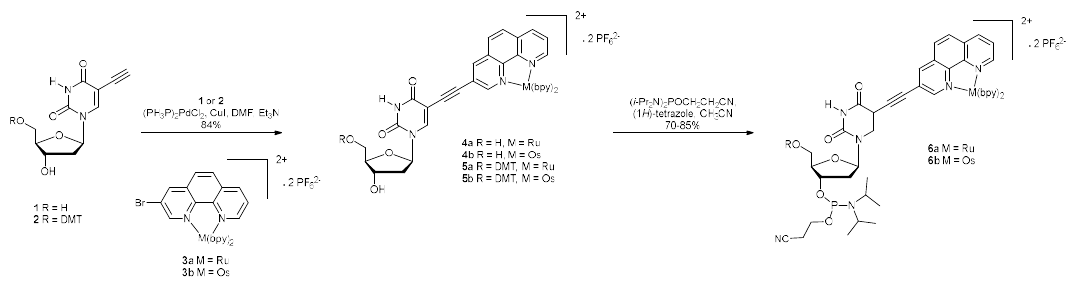
Figure 4. Structure of the Ru(II)-22 mer used in the mismatch experiments. The metal complex is linked, from the bpy’ ligand to the 5’ end of the duplex by a nine-carbon linker. All combinations (16) of base pairs and mismatches were synthesised [87].